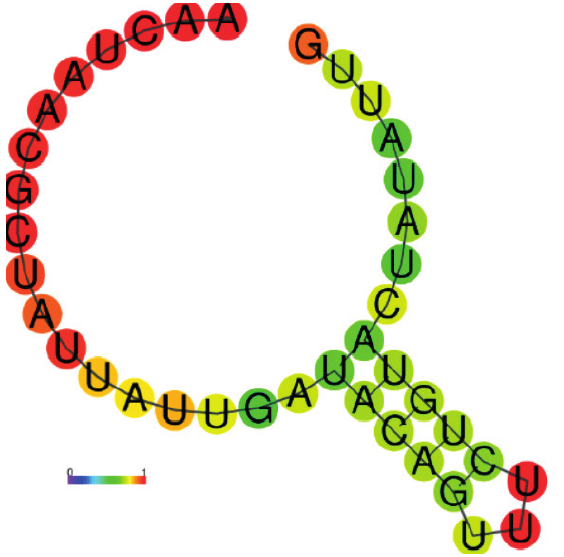
Figure 2 - Predicted mfe secondary structure with base pairing probabilities for the 39 nt spliced leader present in mRNA from T. cruzi . The sequence was folded by RNAfold under default